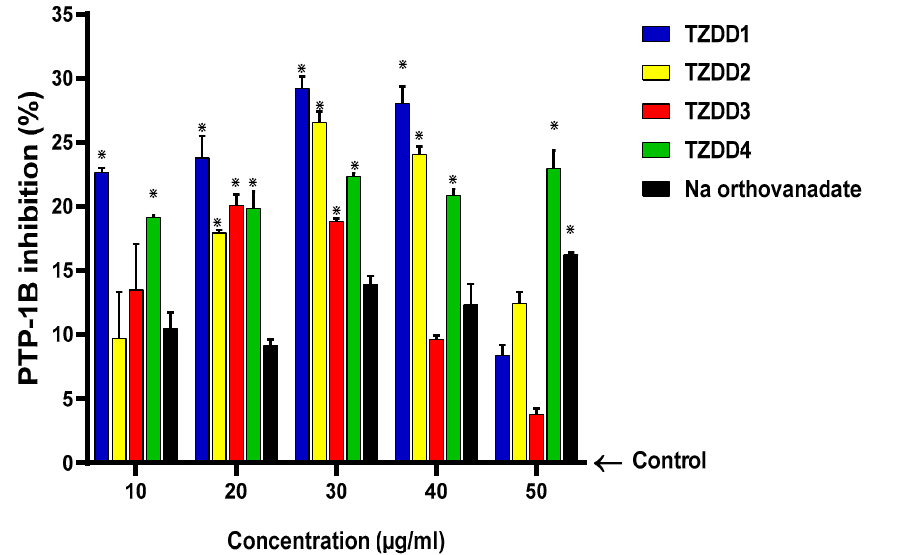
Figure 6. The inhibition of protein tyrosine phosphatase 1B activity by TZD derivatives (10, 20, 30, 40, and 50 µg/mL). The results are represented in a clustered column. Data are presented as mean ± standard deviation values. The error bars correspond to the standard errors of the means, and asterisks (*) indicate a significant statistical difference relative to the control experiment ( p value ≤ 0.05). The arrow from the right pointing at the baseline at 0.0 represents the negative control, which is defined to have zero percent inhibition for the purpose of data normalization.